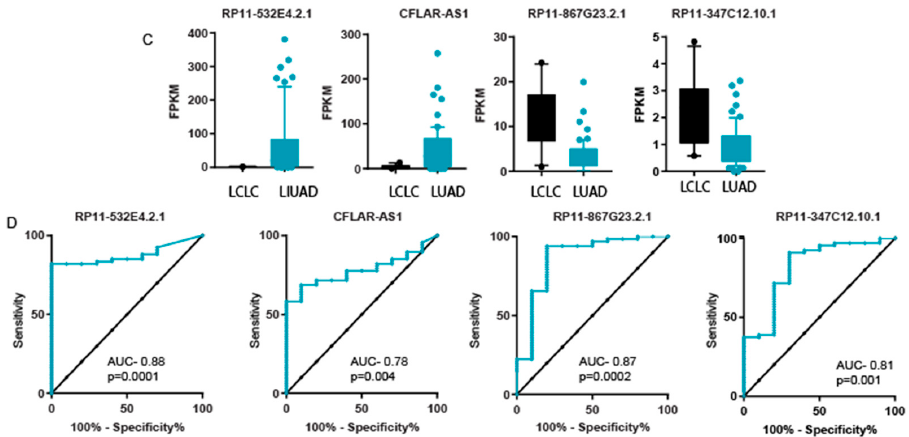
Figure 4. Expression difference in LCLC and LUAD. ( A ) A volcano plot to show the significantly differentially expressed LncRNA in LCLC as compared to LUAD. Black dots show overexpressed genes and blue dots show underexpressed LncRNAs. ( B ) List of top 5 underexpressed and top 5 overexpressed LncRNA in LCLC compared to LUAD. ( C ) The Box plot representing the expression level of indicated LncRNAs. The whiskers show the 10th and 90th percentile of expression. ( D ) Curves representing results of ROC analysis performed to show the sensitivity and specificity of mentioned LncRNA in LCLC vs. LUAD tumors.